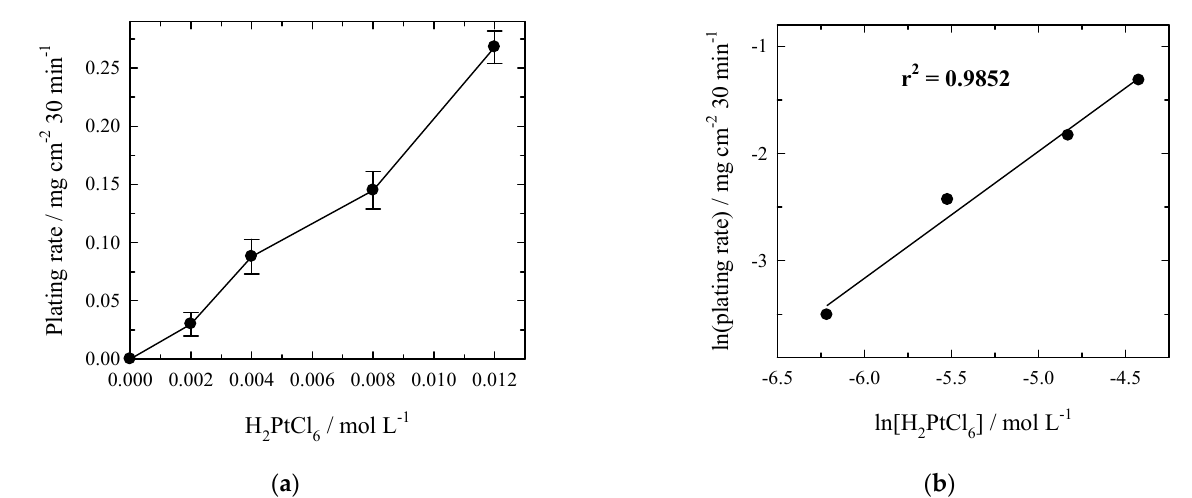
Figure 5. ( a ) Effect of Pt 4+ concentration on the rate of electroless Pt plating under conditions with Ar bubbling. Solution composition (mol L − 1 ): CoCl 2 —0.2; NH 4 OH—0.4; complexing agent—0.16; HCl to pH = 7.5; t dep = 30 min; 20 ◦ C. ( b ) Dependence of natural logarithmic plating rates of Pt vs. natural logarithmic bulk concentrations of H 2 PtCl 6 .